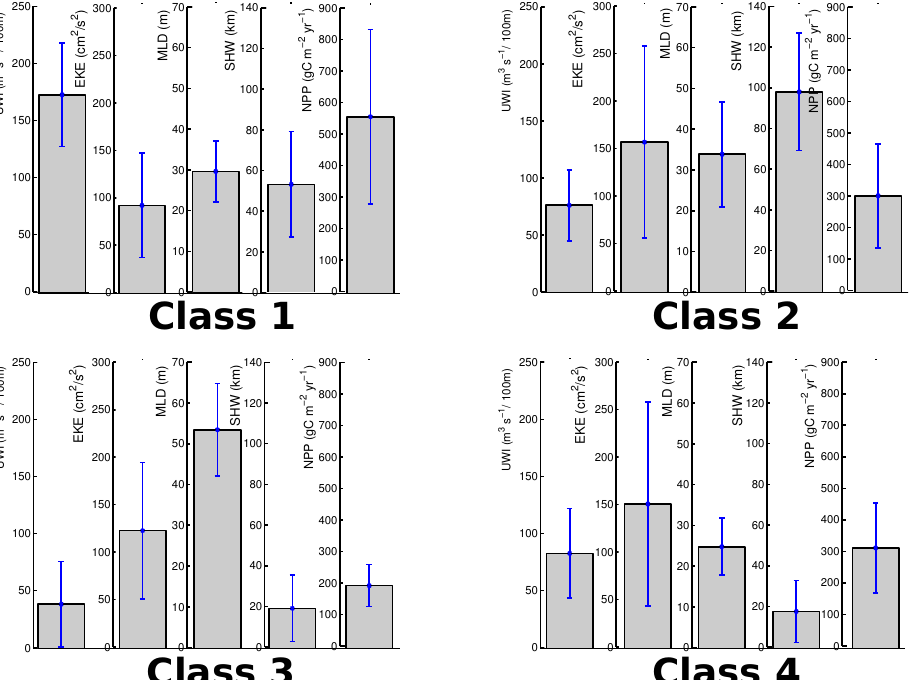
Fig. 9. Mean (grey bars) and ± standard deviation (blue error bars) of upwelling index, eddy kinetic energy, mixed layer depth, shelf width and net primary production associated with each of the 4 classes presented in Fig. 7.